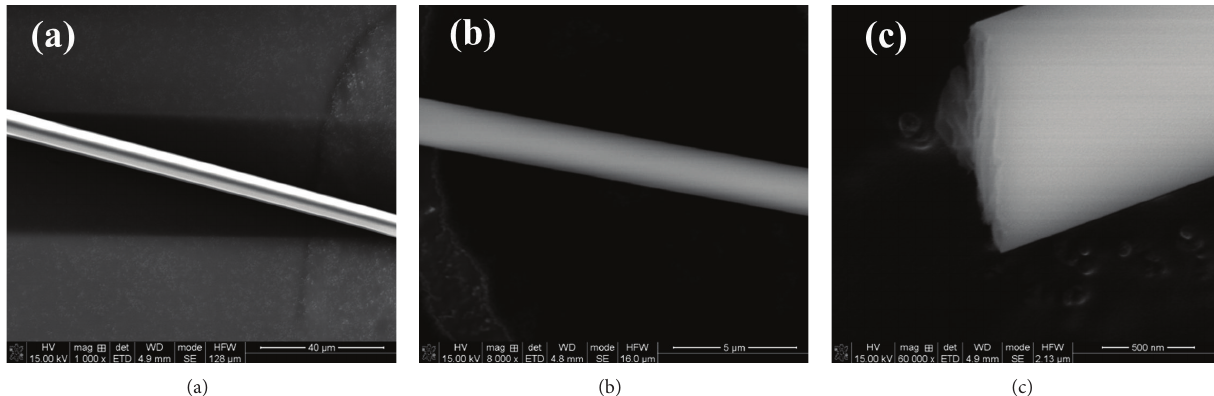
Figure 5: SEM images of microfibers: (a) a 8 𝜇 m-diameter microfiber; (b) a 2.2 𝜇 m-diameter microfiber; (c) a 1.5 𝜇 m-diameter microfiber.